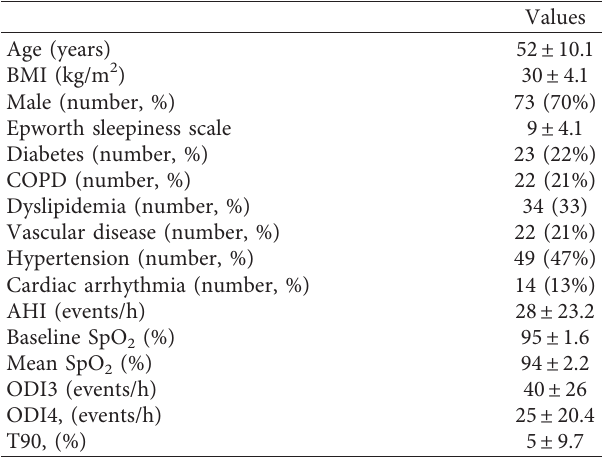
Table 1: Demographic and clinical information for the 104 subjects included in the